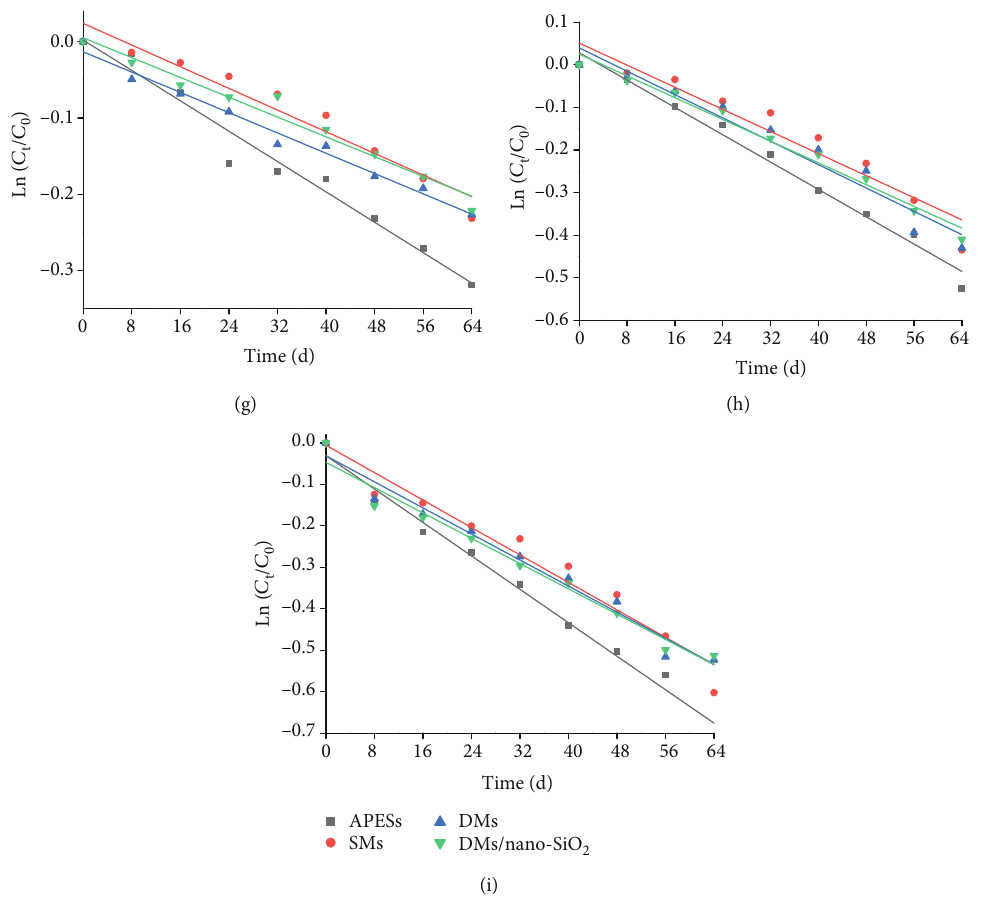
Figure 6: The fi rst-order kinetic plots for APESs, SMs, DMs, and DMs/nano-SiO kinetic plots for samples under light. (b – e) The fi rst-order kinetic plots for samples under di ff erent temperatures (4, 20, 40, and 60 ° C). (f – i) The fi rst-order kinetic plots for samples under di ff erent relative humidities (11, 33, 53, and